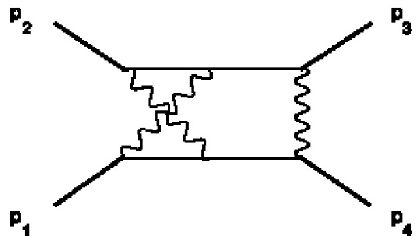
Figure 13. Bhabha | non-planar